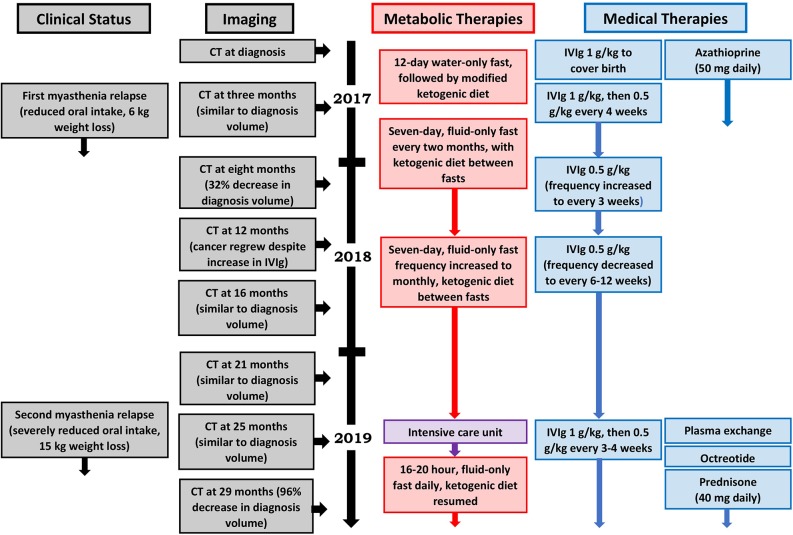
Patient timeline.